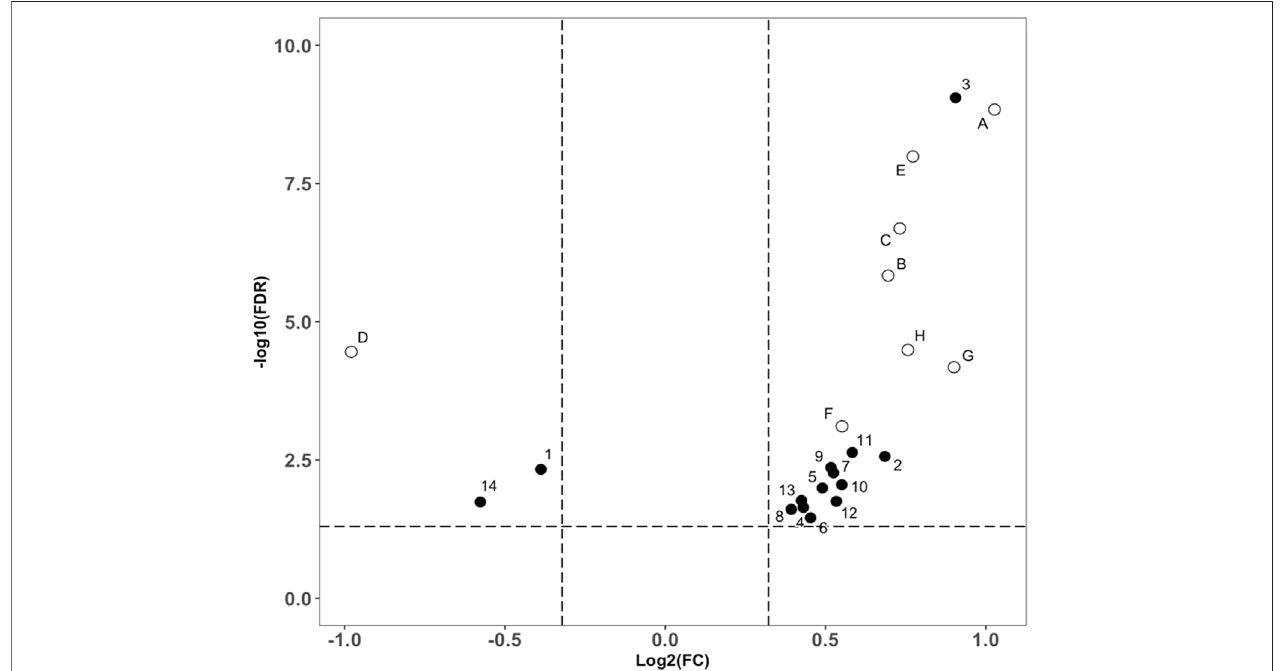
FIGURE 3 | Volcano plot analysis of the biomarker compounds revealed in our discovery analysis with the T2DM training cohort. Filled circles representing compounds discovered from the targeted metabolomics analysis. (A) : Glucose ([M + Na]+), (B) : 2-Ketobutyric acid, (C) : 3-Methylglutaconic acid, (D) : 1,5- anhydroglucitol, (E) : Glucose ([M-H]-), (F) : Galactitol, (G) : Sucrose, (H) : Feruloylquinic acid. Open circles representing compounds discovered from the global metabolomics analysis, 1: Pyroglutamic acid, 2: Ornithine, 3: Hexose, 4: Valine, 5: Leucine/Isoleucine, 6: Tyrosine, 7: Phenylalanine, 8: Tryptophan, 9: C16- Carnitine,10:C14-Carnitine,11:C5DC-Carnitine/C6OH-Carnitine,12:C5OH-Carnitine,13:TritriacontanoicAcid(33:0)ButylEster,and 14:DotriacontanoicAcid(32:0) Butyl Ester.